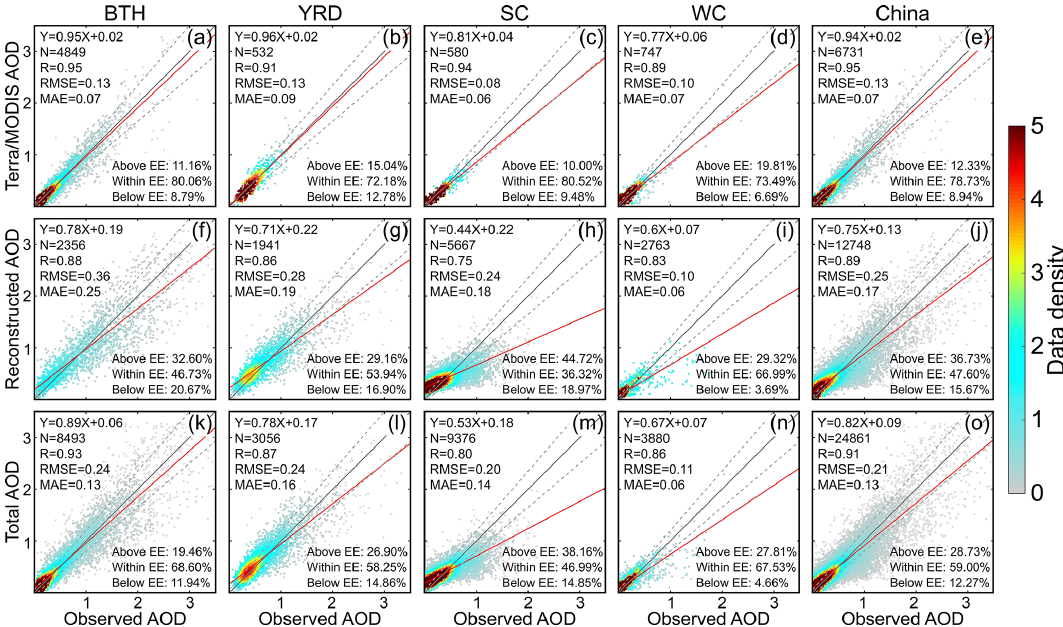
Figure 2. Scatterplots between ground-observed and satellite-based AOD data in different regions of China. (a–e) Original Terra MODIS AOD, (f–j) reconstructed AOD, and (k–o) combined AOD between original and reconstructed data. BTH, YRD, SC, and WC refer to the regions of Beijing–Tianjin–Hebei, Yangtze River Delta, South China, and West China,